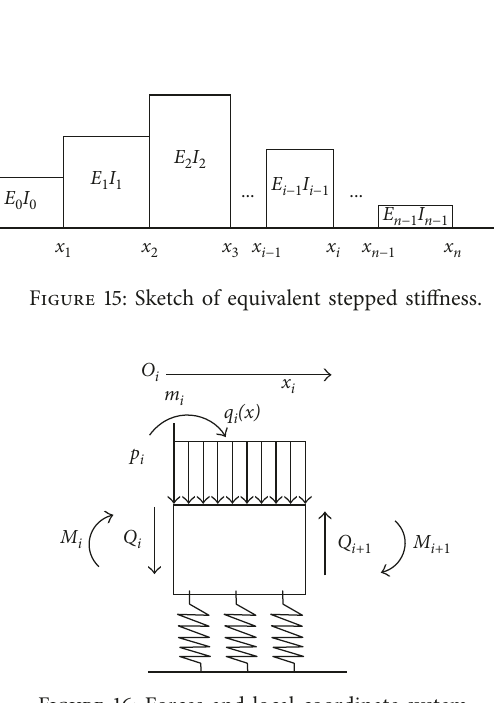
Figure 16: Forces and local coordinate system.